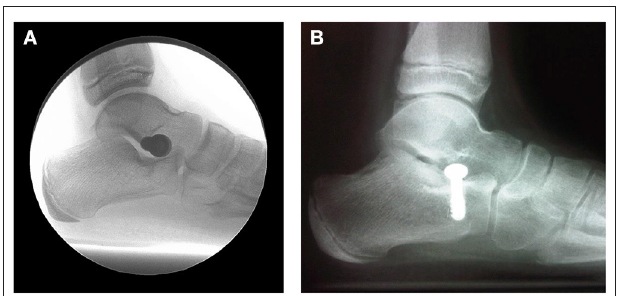
FIGURE 7 | (A) Lateral weightbearing radiograph of an extra-osseous sinus tarsi implant. (B) Intra-osseous screw acting to stabilize the talotarsal